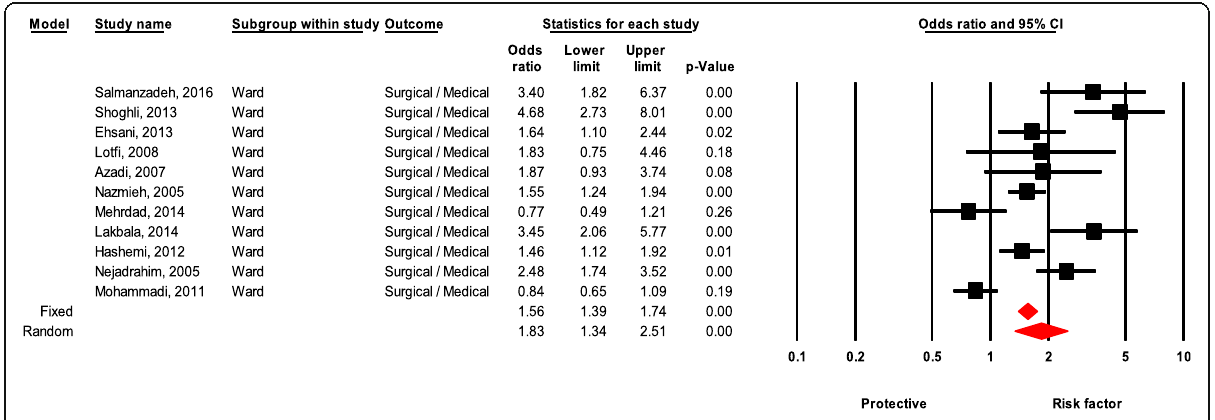
Fig. 11 Forest plot for relationship between ward in hospital and risk of NSI in